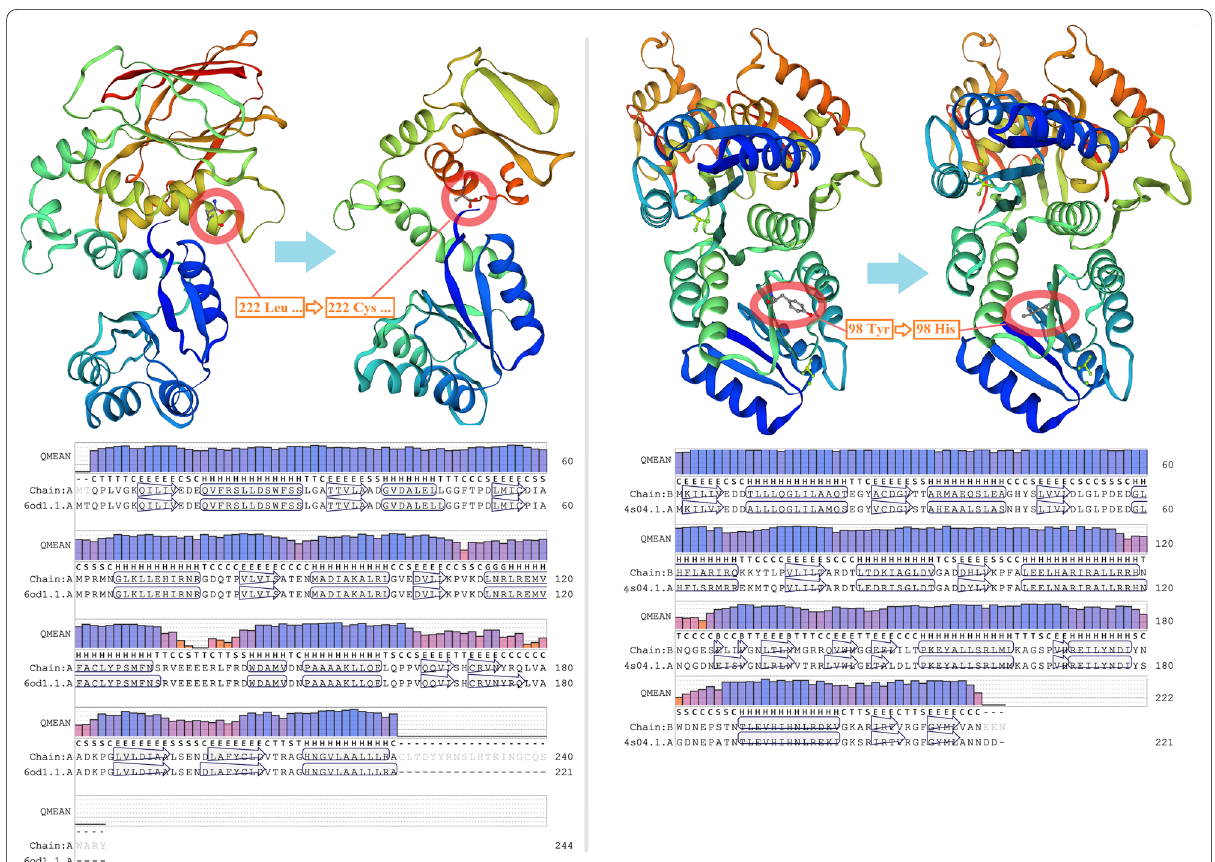
Fig. 4 Three-dimensional structure and sequence alignment of the original and mutated proteins RssB ( A ) and BasR ( B ). The three-dimensional structure was modeled by SWISS-MODEL and modified by Chimera v_1.15 using a PDB file, showing a rainbow ribbon diagram, in which blue color denotes the starting point of the peptide and red stands for the endpoint. The mutation in RssB has occurred at the 222nd amino acid within the α-helix structure and in BasR is at the 98th amino acid within the β-sheet structure. The framed sequences shown in the sequence-alignment panels are involved in protein structures like α-helix, β-sheet, and